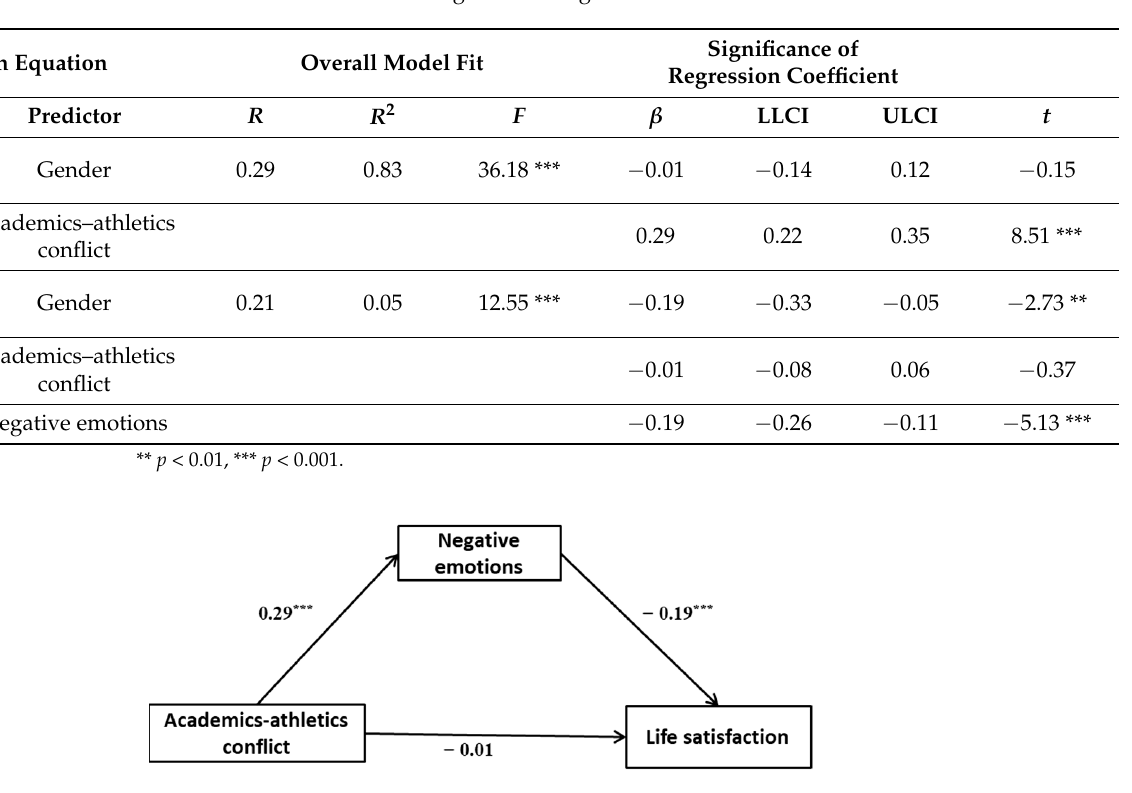
Table 2. Test results of mediating effect of negative emotions.